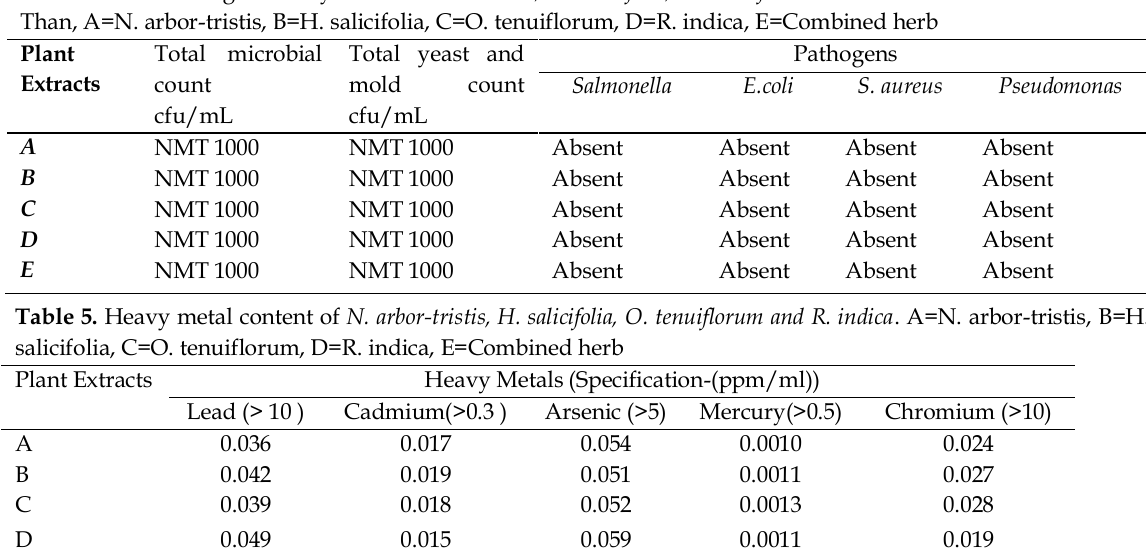
Table 6: Inorganic elements of N. arbor-tristis, H. salicifolia, O. tenuiflorum and R. indica. Note: A= N. arbor- tristis, B=H. salicifolia , C=O. tenuiflorum , D= R. indica , E=Combined herb; Al=Aluminum, Co=Copper, Ca=Calcium,